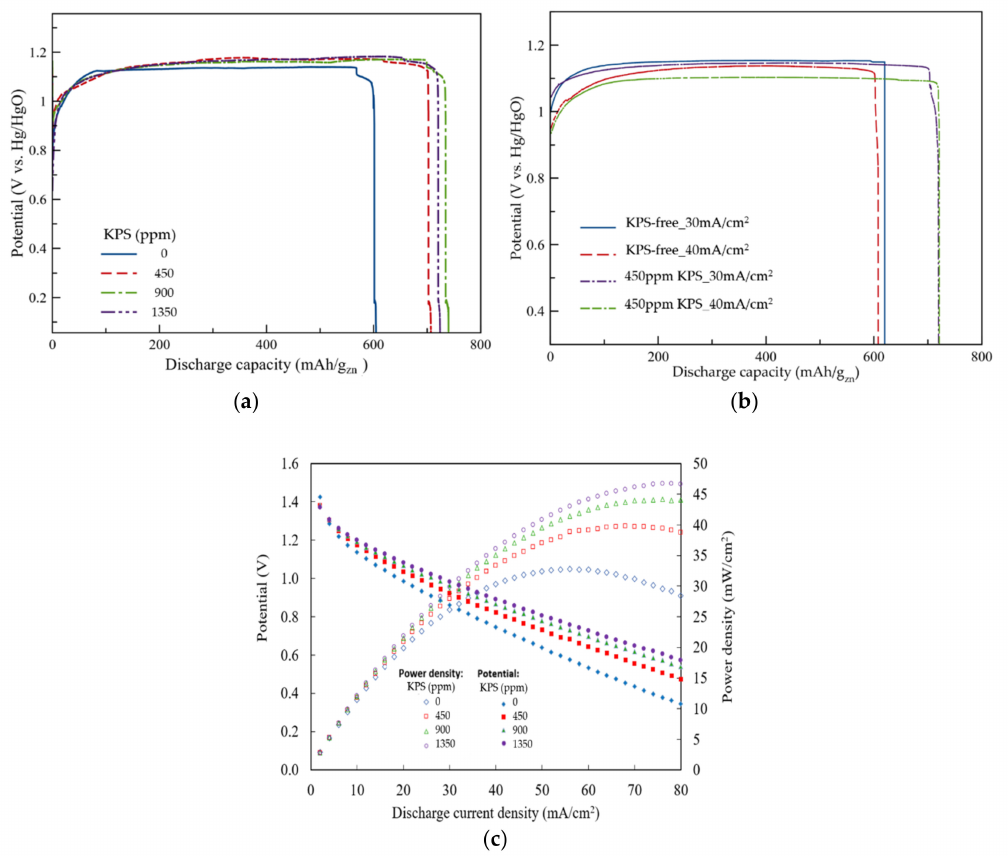
Figure 4. Performance of the zinc–air flow batteries (ZAFBs): ( a ) galvanostatic discharge profiles of the batteries, using di ff erent electrolytes, having an electrolyte circulation rate of 100 mL / min at a current density of 15mA / cm 2 and ( b ) galvanostatic discharge profiles of the batteries containing 0 and450ppmKPSatcurrentdensitiesof30and40mA / cm 2 . ( c )Polarizationcharacteristicsofthebatteries, using di ff erent electrolytes, having an electrolyte circulation rate of 100 mL /